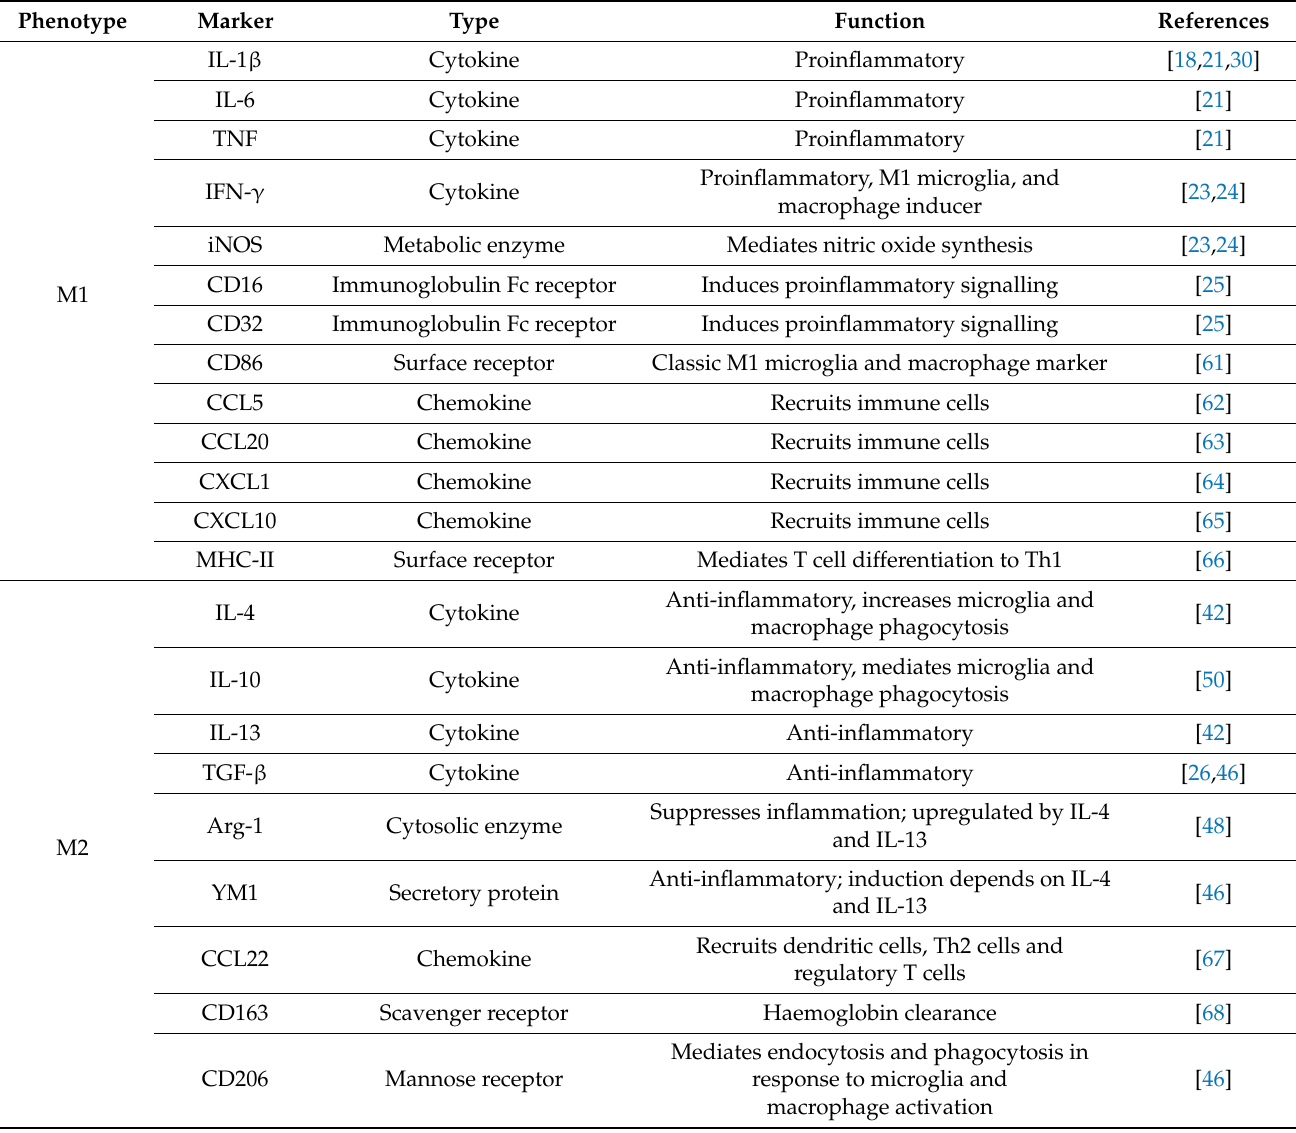
Table 1. Markers and function of M1 and M2